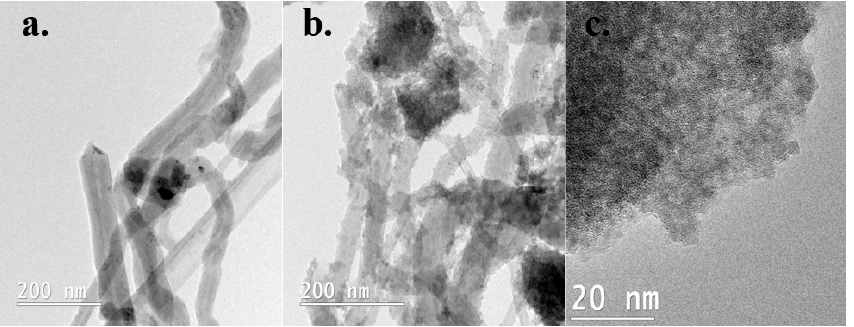
Figure 2. TEM images of ( a ) pure acid-treated MWCNT, ( b ) 50 FHY/50 MWCNT composite, and ( c ) pure synthesized FHY.